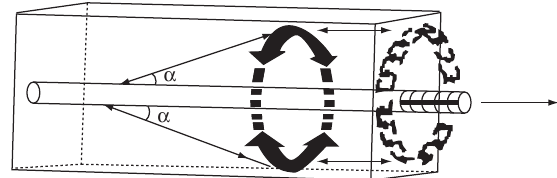
Figure 1. Representation of the radial component of by strength bond in the anchorage zone (Tepfers,